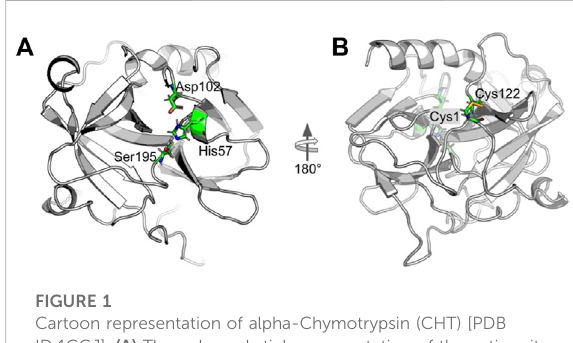
FIGURE 1 Cartoon representation of alpha-Chymotrypsin (CHT) [PDB ID:1CGJ]. (A) The coloured stick representation of the active site catalytic triad; showing the active site residues [His-57; Asp-102; Ser-195]. (B) At the N-terminal, the coloured stick representation [Cys-1; Cys-122] shows the molecular recognition site [External ANS binding site]. This site is located almost opposite to the catalytic